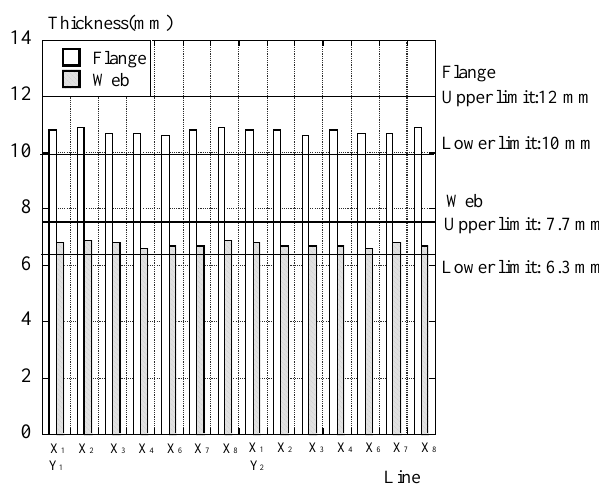
Figure 9. Thickness of the flange and web of the column.